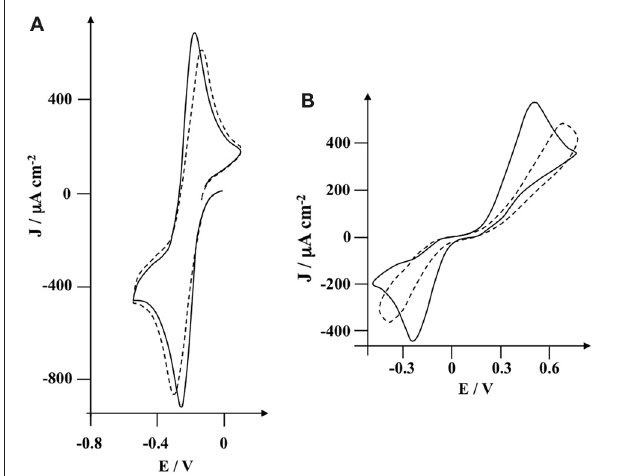
FIGURE 4 | Cyclic voltammogram of (A) ruthenium hexamine (2 × 10 − 3 mol L − 1 ) (B) hydroquinone (2 × 10 − 3 mol L − 1 ) at a glassy carbon electrode modified with poly(pyrrole-lactosyl) film ( (cid:2) = 3 × 10 − 9 mol cm − 2 ) before (line) and after (dashed line) incubation with PNA (8 . 3 × 10 − 6 mol L − 1 ) in 0.1mol L − 1 phosphate buffer (pH = 7 . 2). Scan rate at 0.1V s − 1